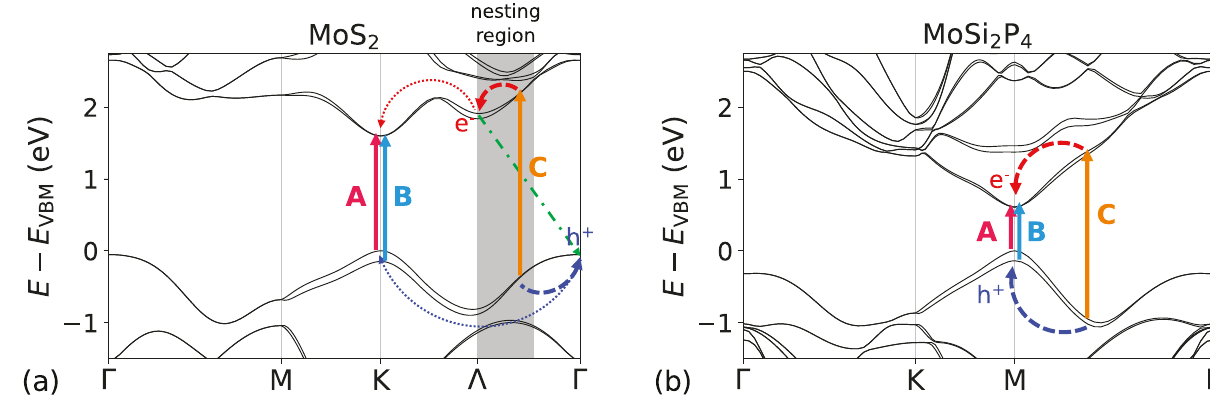
Fig. 5 Relaxation. Relaxation processes of the excited charge carriers from peak C in a MoS 2 and b MoSi 2 P 4 .